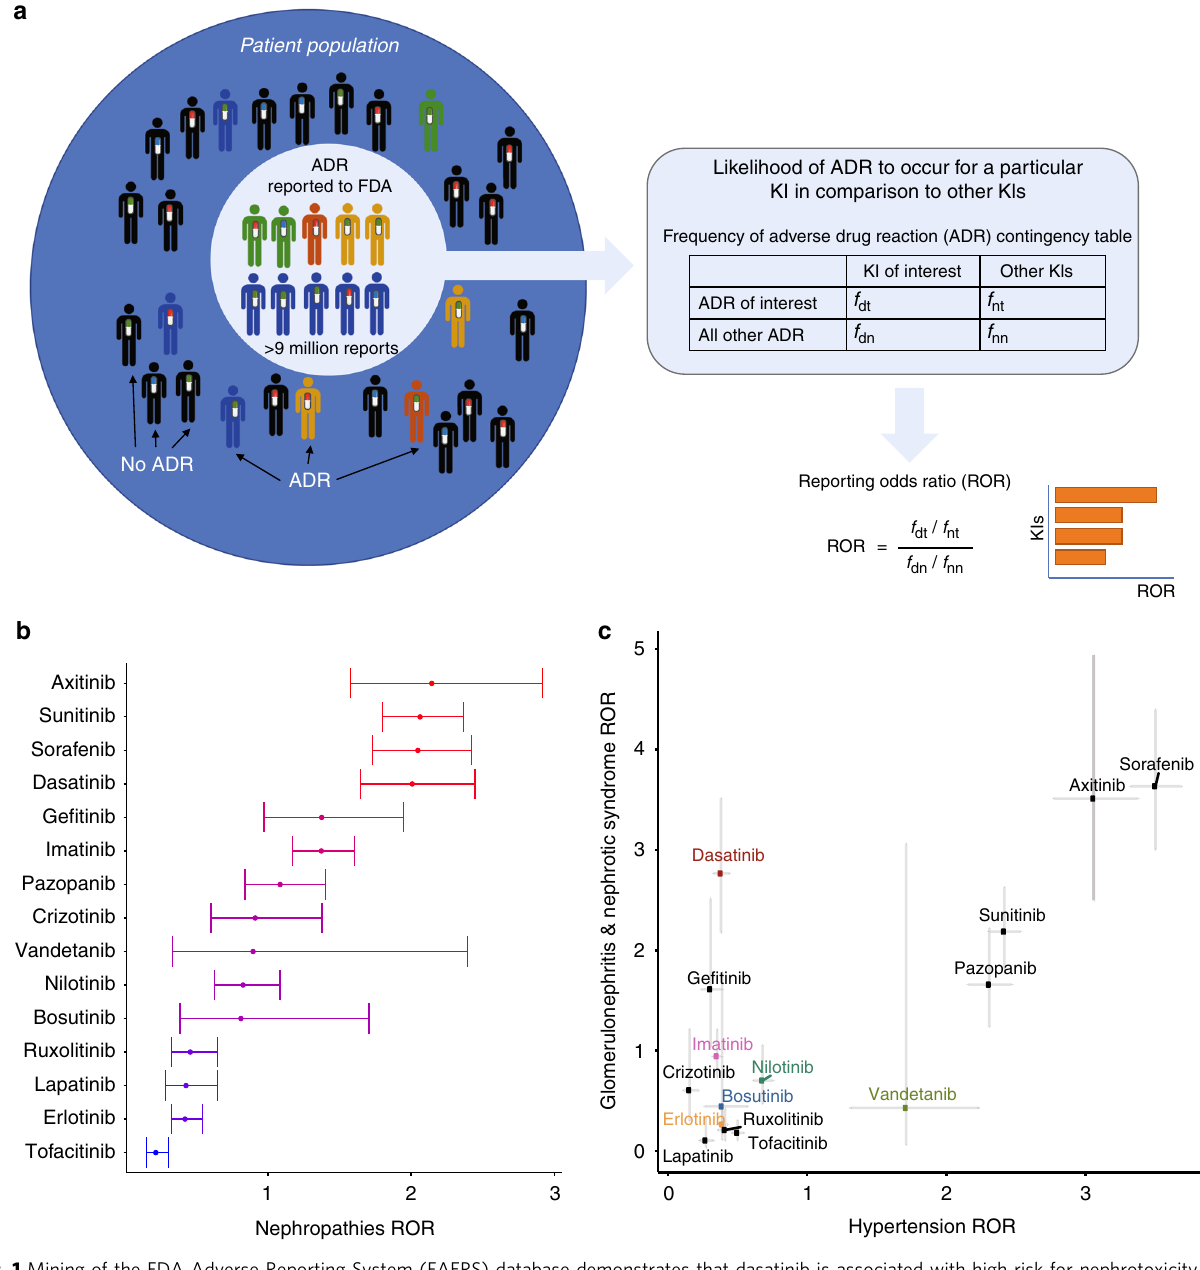
Fig. 1 Mining of the FDA Adverse Reporting System (FAERS) database demonstrates that dasatinib is associated with high risk for nephrotoxicity. a Work fl ow for FAERS database mining. b Dasatinib ranked as one of the highest reporting odds ratio (ROR) for all nephropathies among other KIs in the FAERS database. c When the KI ROR values for glomerular speci fi c nephropathies are plotted against those for hypertension, dasatinib is seen as a clear outlier with high risk for glomerular disorder and a relatively low risk for